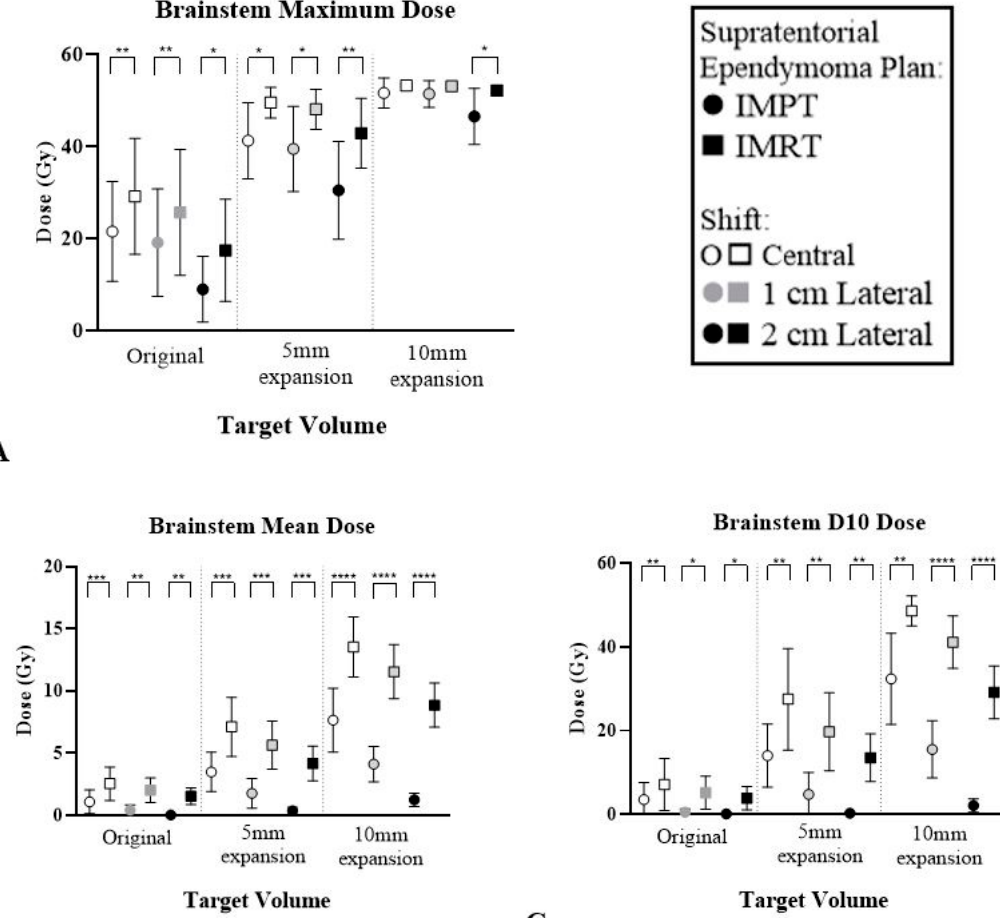
Figure 6. Average dose to brainstem across six patients across IMPT and IMRT plans for three STEP volumes and locations. ( A ) Maximum dose. ( B ) Mean dose. ( C ) Dose to 10% of the structure. Paired t -test error bars represent the 95% confidence interval of the mean. * p < 0.05, ** p < 0.01, *** p < 0.001, **** p < 0.0001.